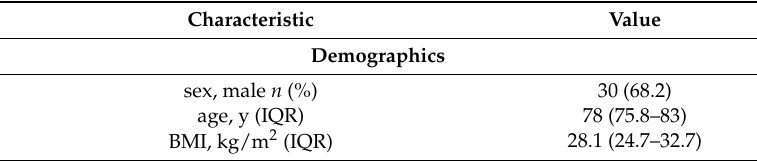
Table 1. Baseline characteristics of 44 patients with successful left atrial appendage closure and biomarker